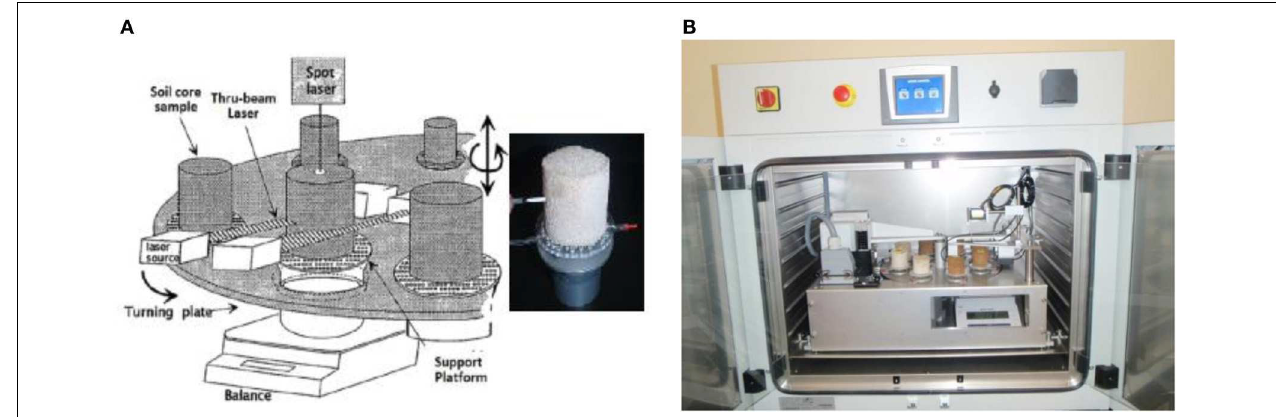
can hold up to eight soil samples where the soil sample’s height, diameter, weight, and water succion are taken at 10min intervals and under the same conditions.